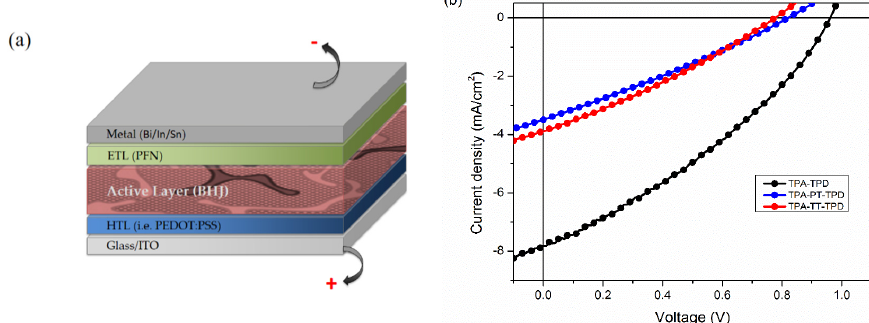
Figure 4. ( a ) Organic solar cells (OSCs) with the ITO/PEDOT:PSS/SM:PC71BM/PFN/FM architecture; ( b ) Current density-voltage characteristics of OSC devices based on TPA-TPD , TPA-PT-TPD and TPA-TT-TPD .